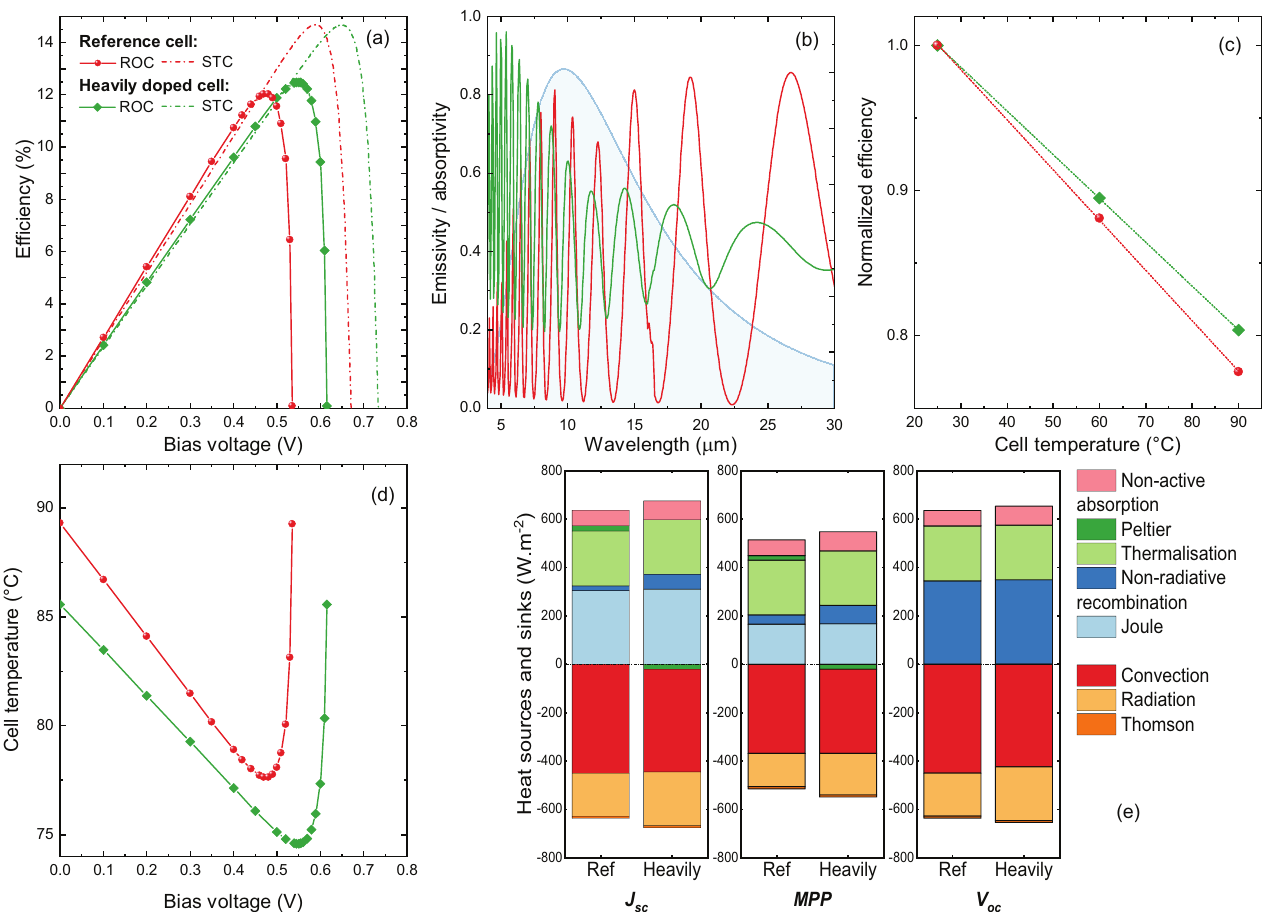
Fig. 5. (a) Power conversion ef fi ciency of the two cells (reference in red and highly doped in green) under standard test conditions (dotted lines) and under real operating conditions (solid lines). (b) Spectral absorptivity under normal incidence of the two solar cells (reference cell in red and heavily doped cell in green), which is the ratio of the absorbed to the incident solar power. According to Kirchhoff ’ s law of radiation, the absorptivity is equal to the spectral emissivity, which is the ratio of the radiation emitted to the radiation emitted by a blackbody at a given wavelength. The emission spectrum of the blackbody at 25 ° C is shown in the light blue. (c) Normalised ef fi ciency ( h / h stc ) as a function of solar cell temperature, from which the temperature coef fi cient b can be extracted by linear fi tting. (d) Temperature-voltage characteristic. (e) Heat sources and sinks of the two cells at three speci fi c operating points: the short-circuit ( J sc ), the maximum power (MPP), and the open-circuit ( V oc